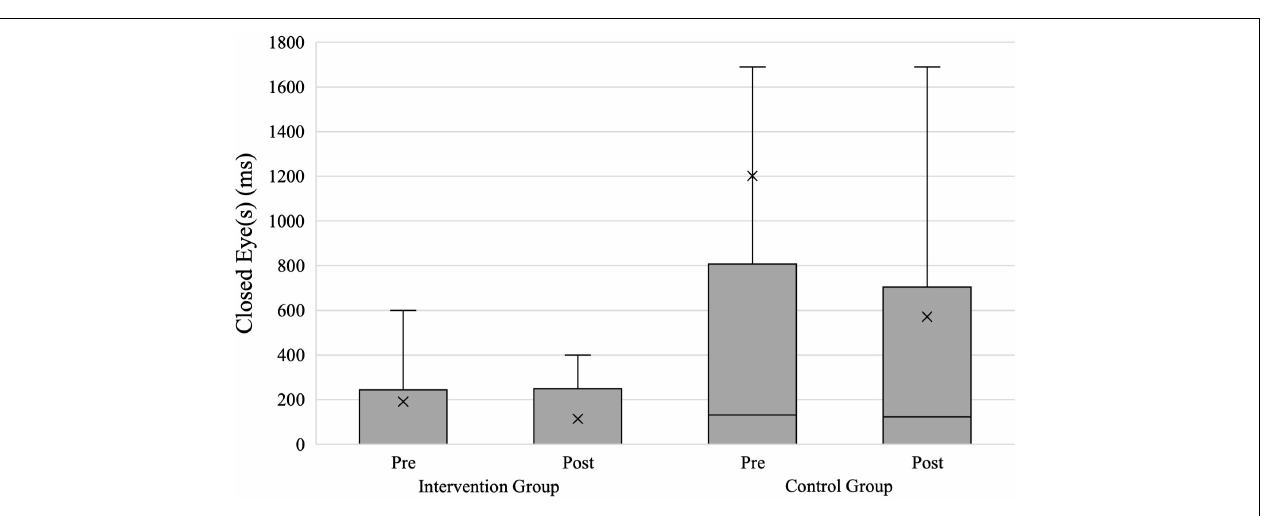
FIGURE 9 | Closed Eye(s) in shoot scenarios for both groups. X, mean